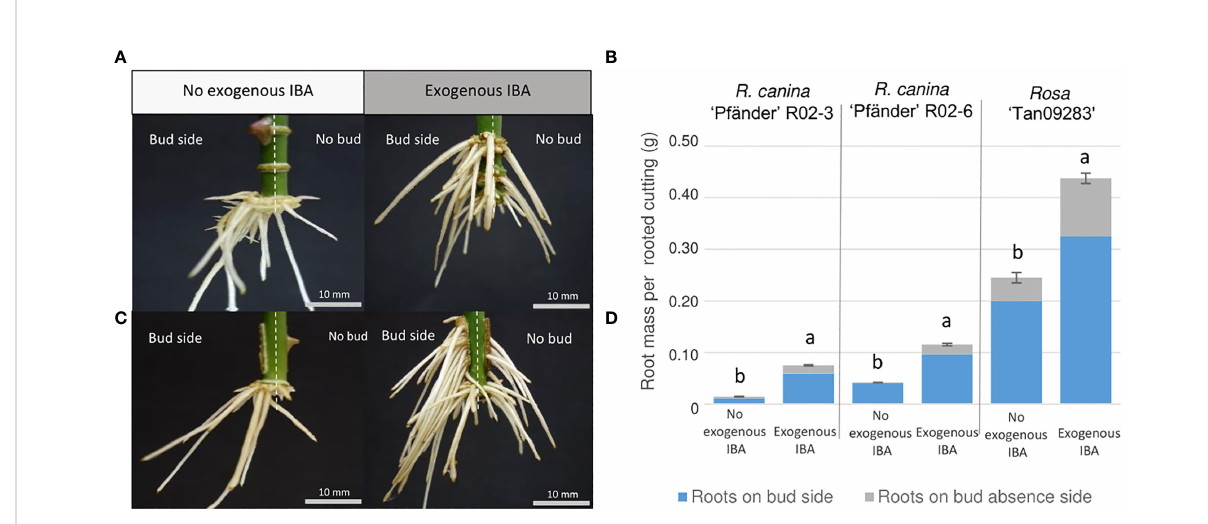
FIGURE 6 Adventitious root distribution regarding bud position by ring (A, B) and strip (C, D) patterns under the effect of exogenous auxin on Rosa ‘ Tan09283 ’ cuttings. Left side: Stem cuttings are divided by vertical dashed white lines describing the division between the bud side and the opposite side of the cutting. Right side: Comparison of root mass ratio in presence and absence of exogenous auxin for Rosa ‘ Tan09283 ’ , R. canina ‘ Pfänder ’ R02-3 and R. canina ‘ Pfänder ’ R02-6. Columns and bars represent the mean values and SE (n= 20 for R. canina ‘ Pfänder ’ R02-3 and R. canina ‘ Pfänder ’ R02-6, n= 40 for Rosa ‘ Tan09283 ’ ). Gray and blue sections in each bar represent the proportion of root mass on the cutting opposite to the bud or below the bud, respectively. Letters represent signi fi cantly different levels for each genotype (Tukey test, p ≤